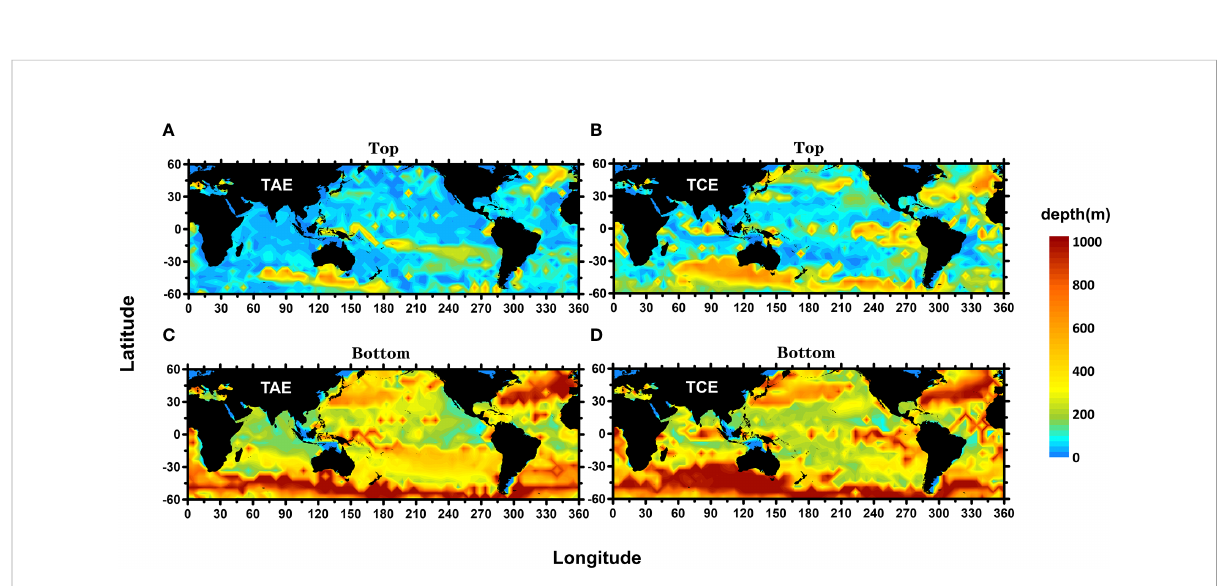
FIGURE 2 Global distributions of eddy core depth at 5° × 5° resolution. The (A, B) panels are the top and bottom of the eddy core depth respectively, and the (C, D) are for TAE and TCE, respectively.